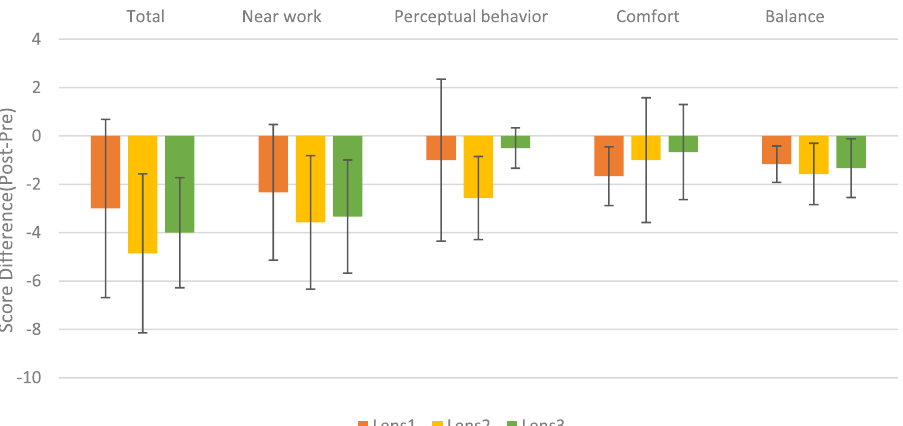
Figure 7. Visual behavior performance score before and after wearing contact lenses; error bars represent the standard deviation.